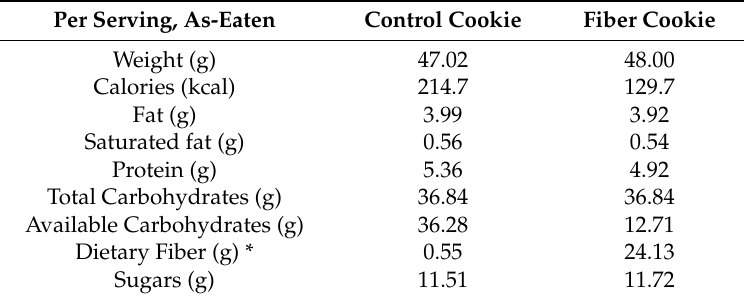
Table 1. Nutrient composition of